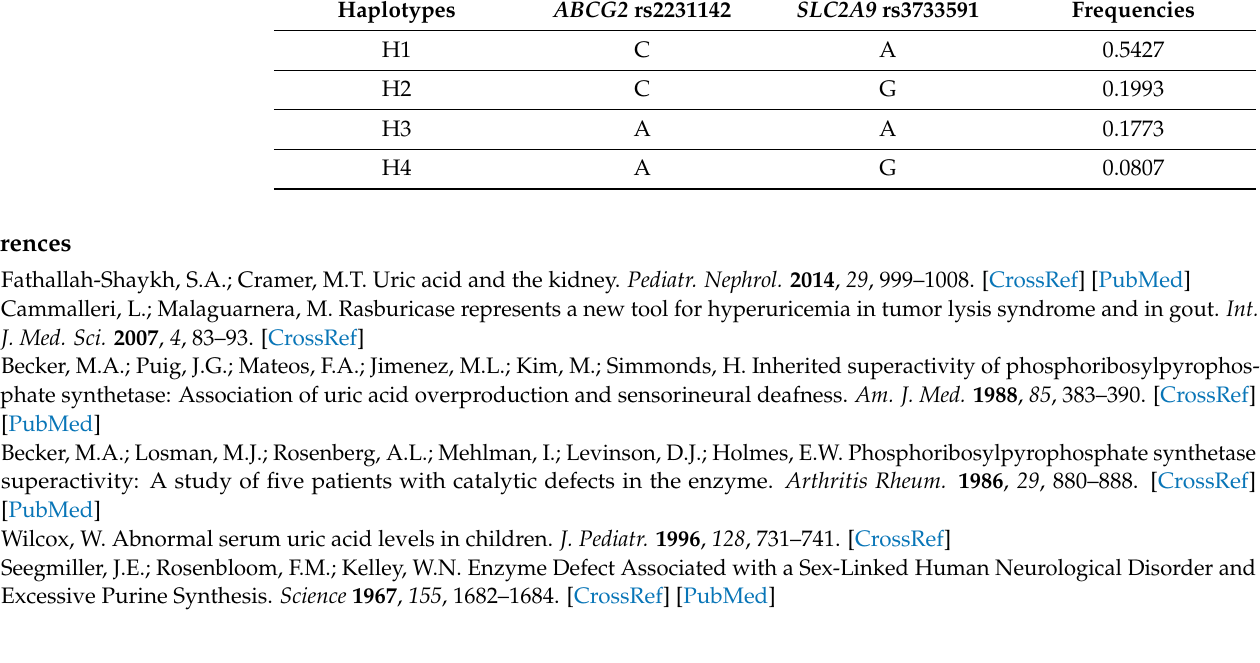
Table A2. Frequencies and number of haplotypes of ABCG2 rs2231142 and SLC2A9 rs3733591.